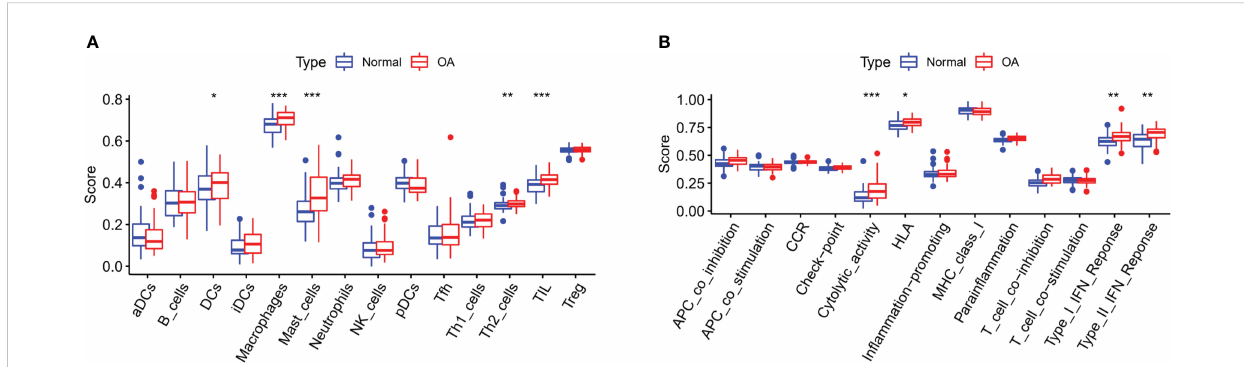
FIGURE 3 Differential expressions of immunocytes and immune-related response pathways in OA. (A) Differential expressions of immunocytes in OA compared to the healthy samples. (B) Differential expressions of immune response pathways in OA compared to the healthy samples. *p < 0.05, **p < 0.01, and ***p <